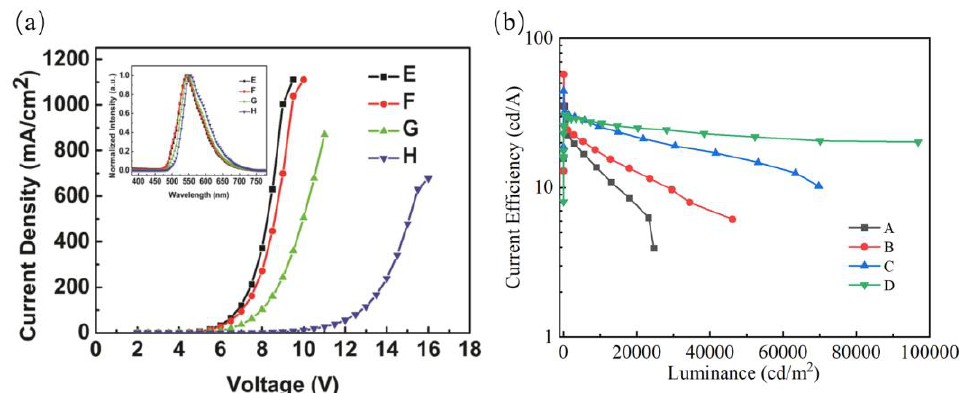
Figure 3. Current density – voltage ( a ) and current efficiency – luminance ( b ) characteristics of the devices E – H. The inset of Figure 3a shows the normalized EL spectra of the devices E – H at 9 V.